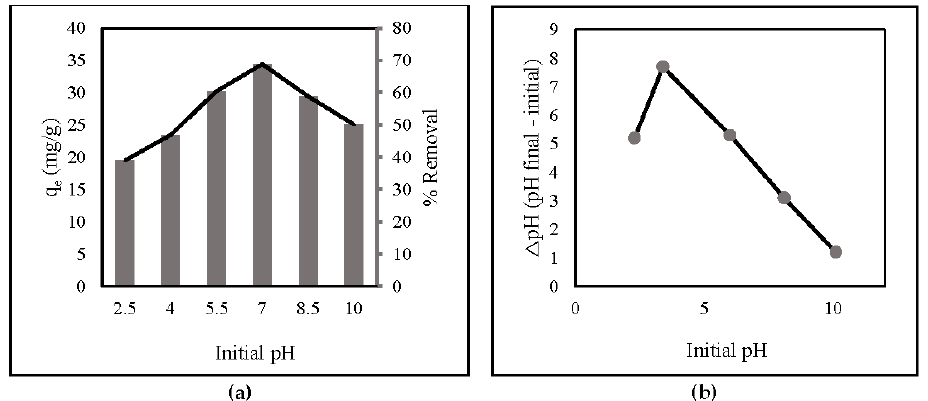
Figure 3. ( a ) Initial pH (10 mg of ZLCH-Fe; initial NO 3 : 10 mg/L; contact time: 30 min); ( b ) pH zpc.